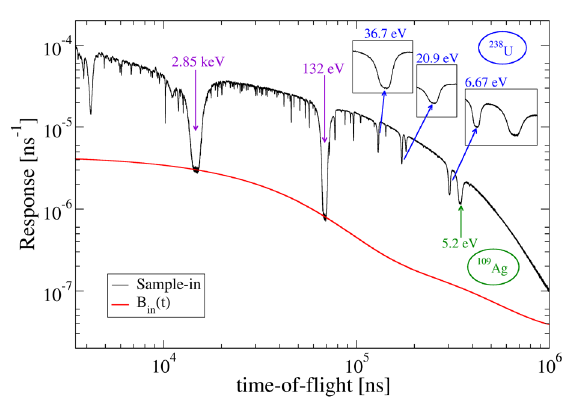
Figure 4. Comparison between the MCNP simulation and the REFIT calculation. Residuals given below each plot are calcu- lated as the di ff erence between the data coming from the MCNP simulation and the REFIT calculation.